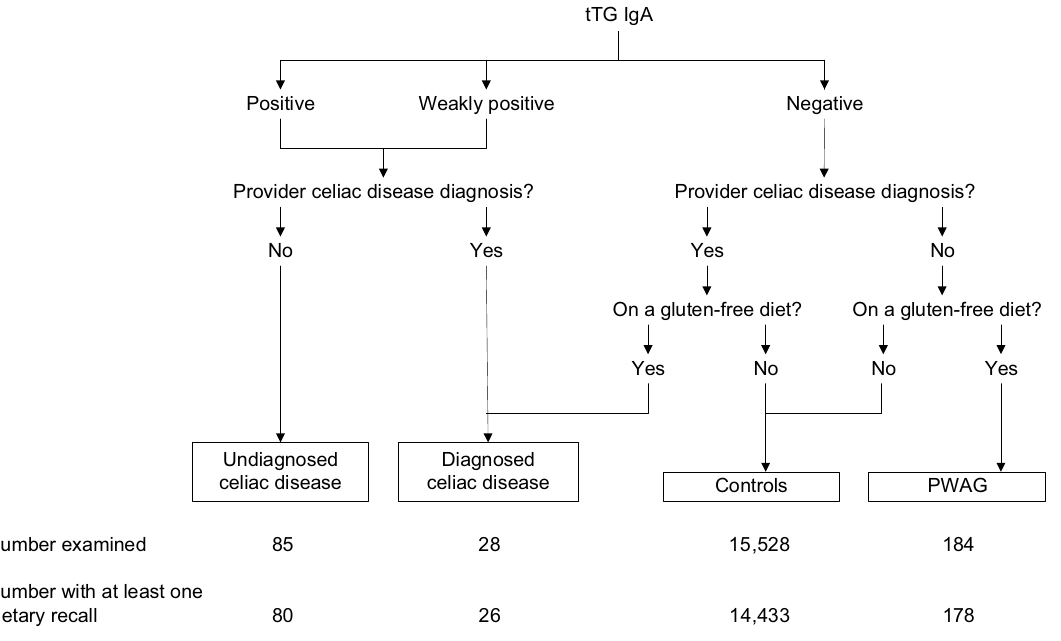
Figure 1. Case definitions and sample sizes for celiac disease, PWAG, and control groups for analyses of nutrient intake among persons with celiac disease and gluten-related disorders in NHANES,